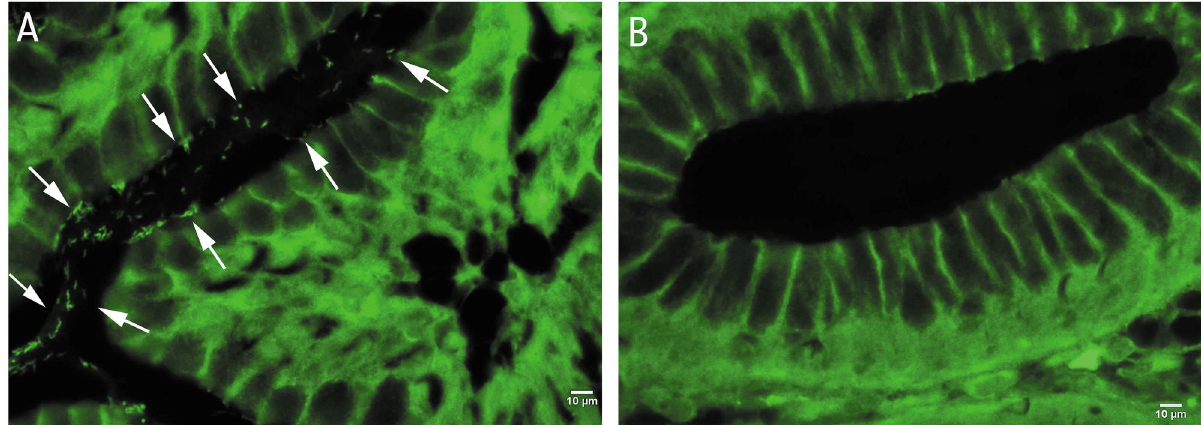
Figure 4. FISH detection of H.pylori in paraffin-embedded sections of gastric biopsies, using 2’-O-methyl/LNA FISH detection conditions. (A) Detection of H. pylori using the HP_LNA/2OMe_PS probe in a histological slide of a gastric biopsy specimen of an infected patient; (B) Experiment control performed in parallel using the HP_LNA/2OMe_PS probe in a histological slide of a gastric biopsy specimen of an non infected patient. Arrows indicate the presence of H. pylori infecting the gastric mucosa. All images were taken at equal exposure times Scale bars: 10 µm. Original magnification of ×1000. doi: